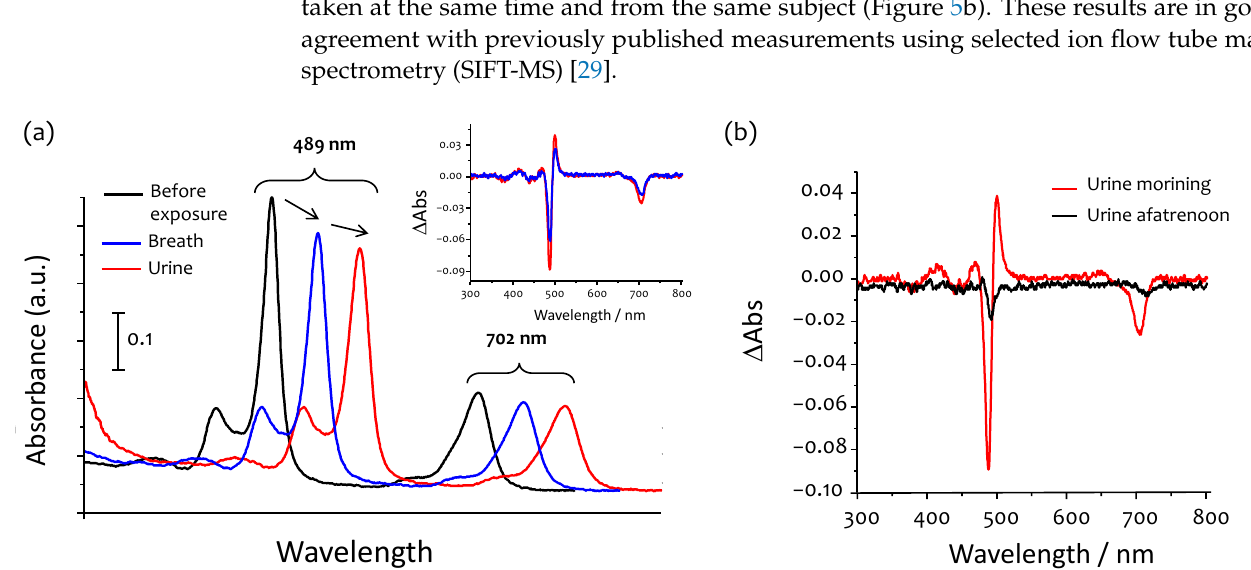
Figure 6. ( a ) UV–vis spectra of the PDDA/TSPP film measured before (after HCl vapor treatment) and after exposure to breath and urine headspace. The inset shows the corresponding difference absorption spectra. ( b ) Difference absorption spectra of the PDDA/TSPP film for urine samples collected in the morning and the afternoon. The spectra in Figure 6a are shifted horizontally for illustration purposes and convenience in reading the figure.